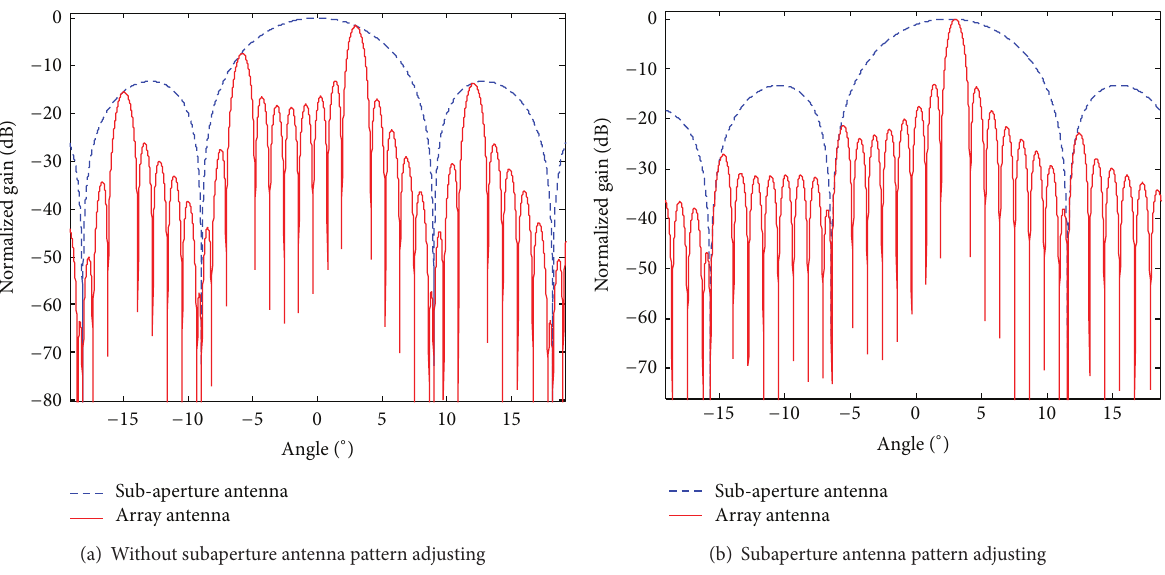
Figure 4: Antenna patterns of the whole receive antenna.